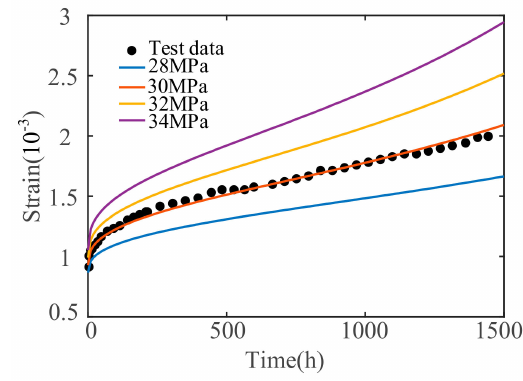
Figure 7. Sensitivity analysis under di ff erent stress σ